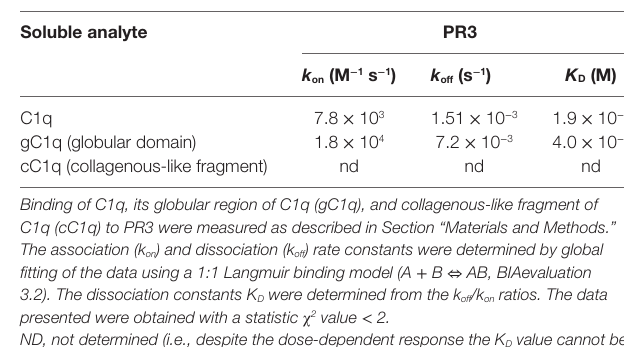
FigUre 2 | C1q binding increases on apoptotic cells that express proteinase 3 (PR3) on their surface. (a) Apoptosis of rat basophilic leukemia (RBL) and RBL-PR3 was analysed by double Annexin V/PI labeling. FSC/SSC dot plot of the irradiated population is shown, and gating strategy used for AV/PI analysis is indicated. Percentages correspond to the AV/PI positive population. (B) Untreated and UV-B irradiated RBL and RBL-PR3 cells were labeled with anti-PR3 antibody. Isotype controls in green for PR3-RBL cells are shown. (c) Cells were incubated with soluble C1q, and its binding was detected using a monoclonal antibody against C1q. Representative experiments are shown. Blue curves correspond to C1q binding on P1 gate (non-irradiated cells) or on P2 gate (UV-irradiated cells). Black curves represent the fluorescence of the P3 gate which appears with apoptosis; green curves represent the fluorescence of cells in the same gate in the absence of C1q. (D) Quantification of the C1q binding as shown in panel (c) , done on the P1 and P3 subsets (three independent experiments, * P < 0.05, Student’s t -test). Analyses were monitored by flow cytometry as described in Section “Materials and Methods.” Abbreviations: FI, fluorescence intensity; MFI, median fluorescence intensity; SSC, side scatter; FSC, forward